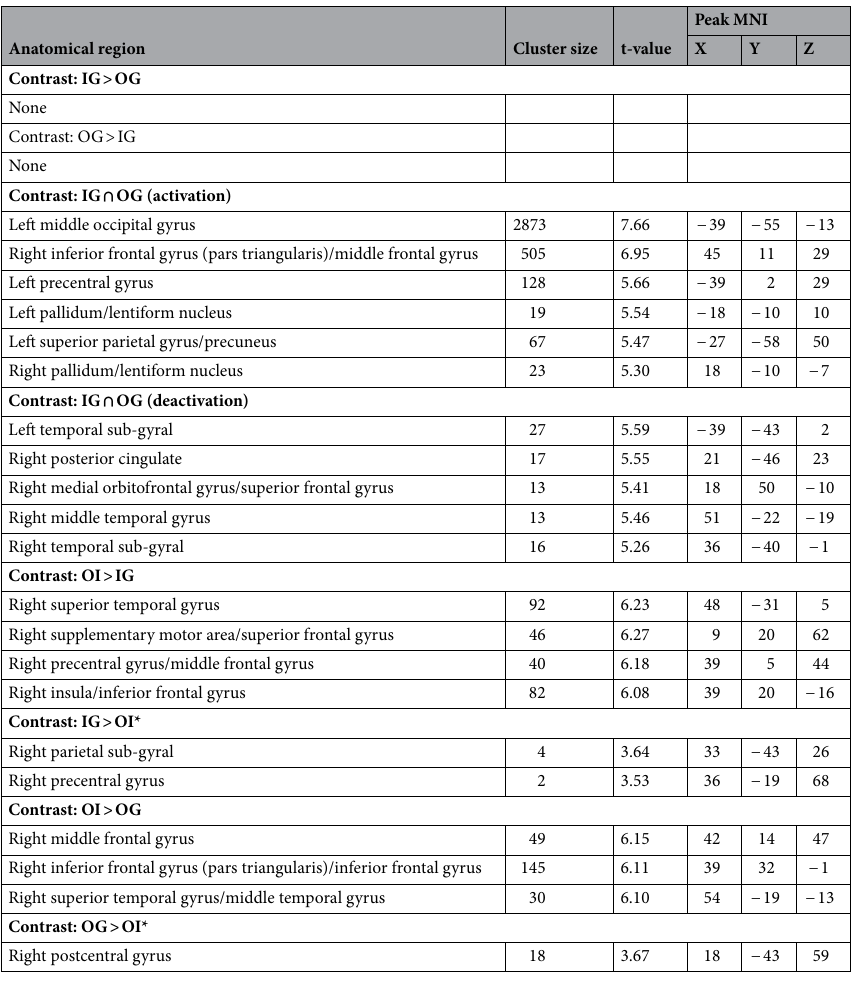
Table 1. Peak MNI coordinates of whole-brain activations from the SPM contrasts (p < 0.05 with FWE correction at the voxel level). Results of contrasts marked with asterisk (*) are reported at p < 0.001